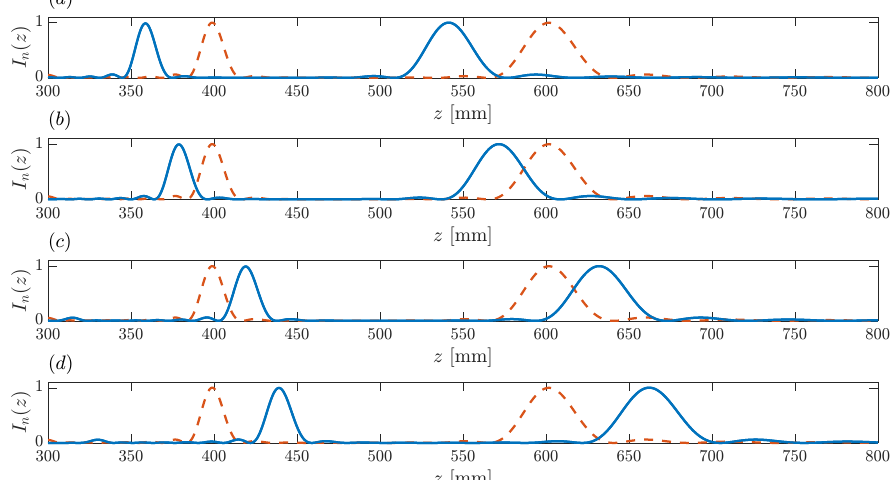
Figure 10. Bifocal ZP focusing profiles vs. axial coordinate for different operating frequencies. Blue solid line: ( a ) f = 9 MHz, ( b ) f = 9.5 MHz, ( c ) f = 10.5 MHz, ( d ) f = 11 MHz. The dashed red line corresponds to an operating frequency equal to the design frequency ( f = 10 MHz).